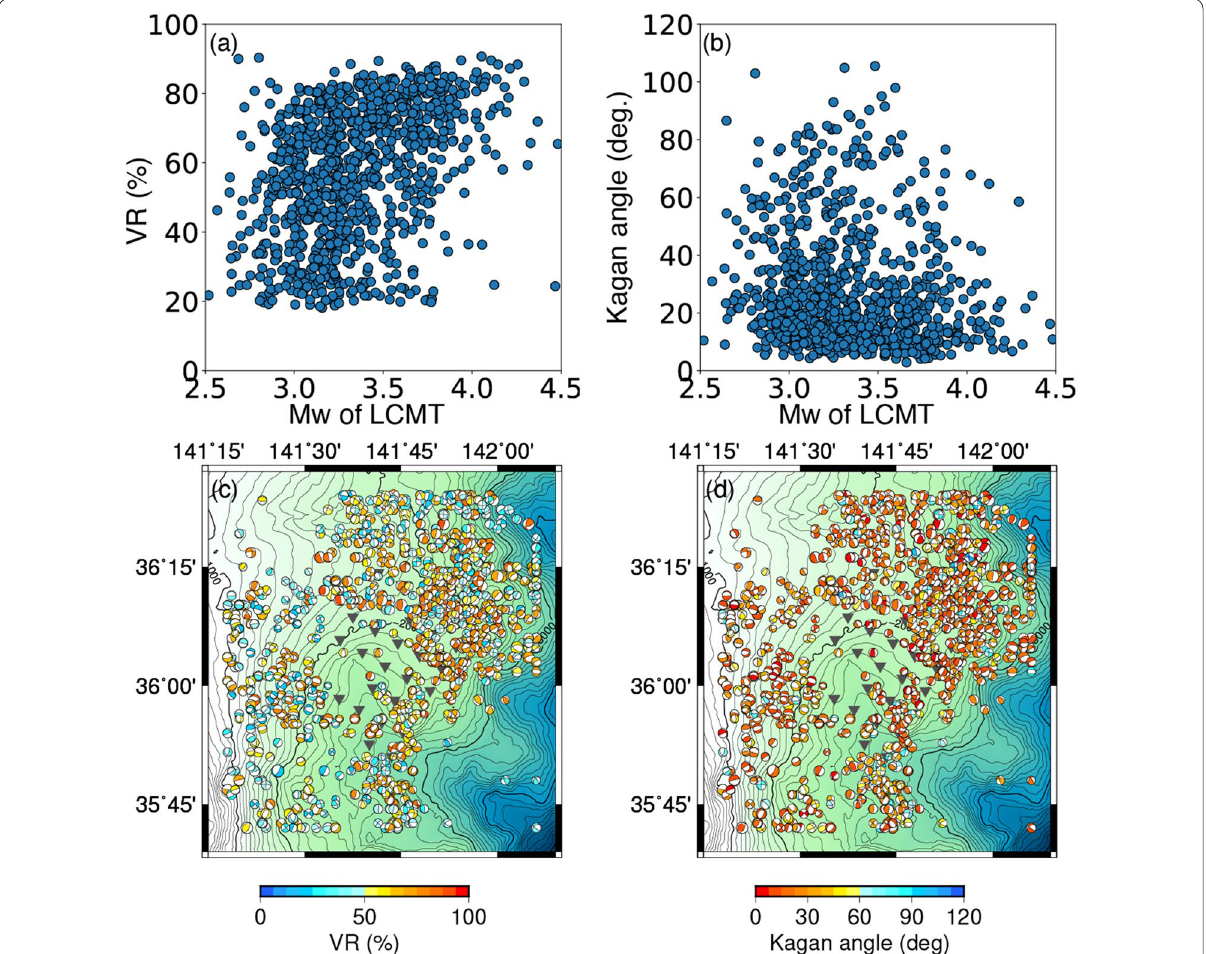
Fig. 2 a Moment magnitudes of the obtained CMT solutions against the VRs, and b the 68% confidence interval of Kagan angle by bootstrap results. c Spatial distribution of the VRs and d of the 68% confidence interval of Kagan